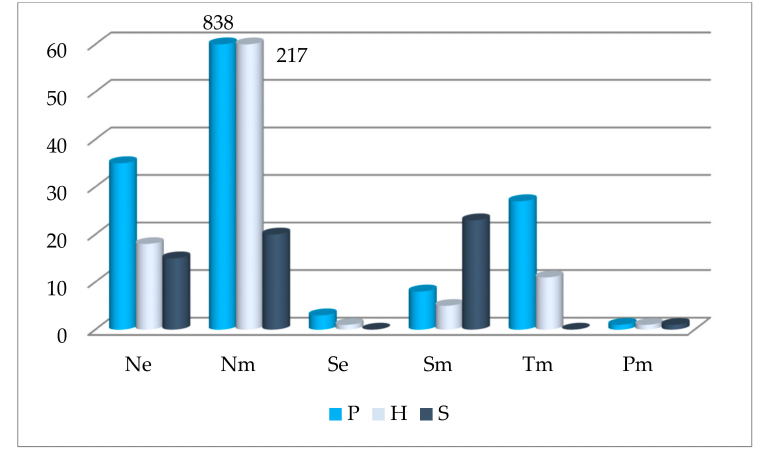
Figure 4. Abundance of oak undergrowth (P—pedunculate oak, H—hybrid oak, S—sessile oak) in different forest sites: Ne—eutrophic soils of normal moisture, Nm—mesoeutrophic soils of normal moisture, Se—eutrophic soils of normal moisture on slopes (>15 ◦ ), Sm—mesoeutrophic soils of normal moisture on slopes (>15 ◦ ), Tm—mesoeutrophic gleyic soils of temporary overmoisture, Pm—mesoeutrophic gley soils of permanent